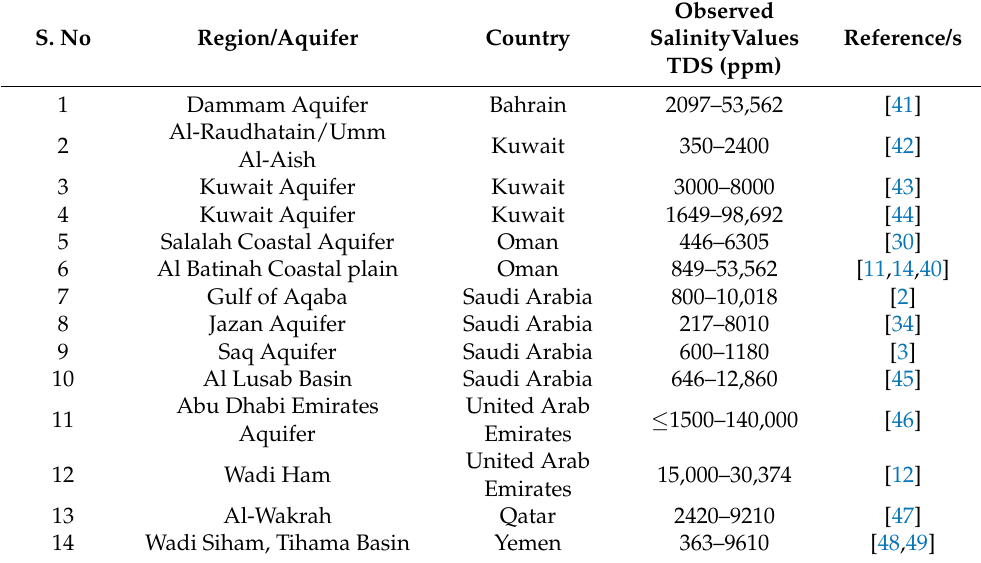
Table 2. Observed salinity values in groundwater at various locations on the Arabian